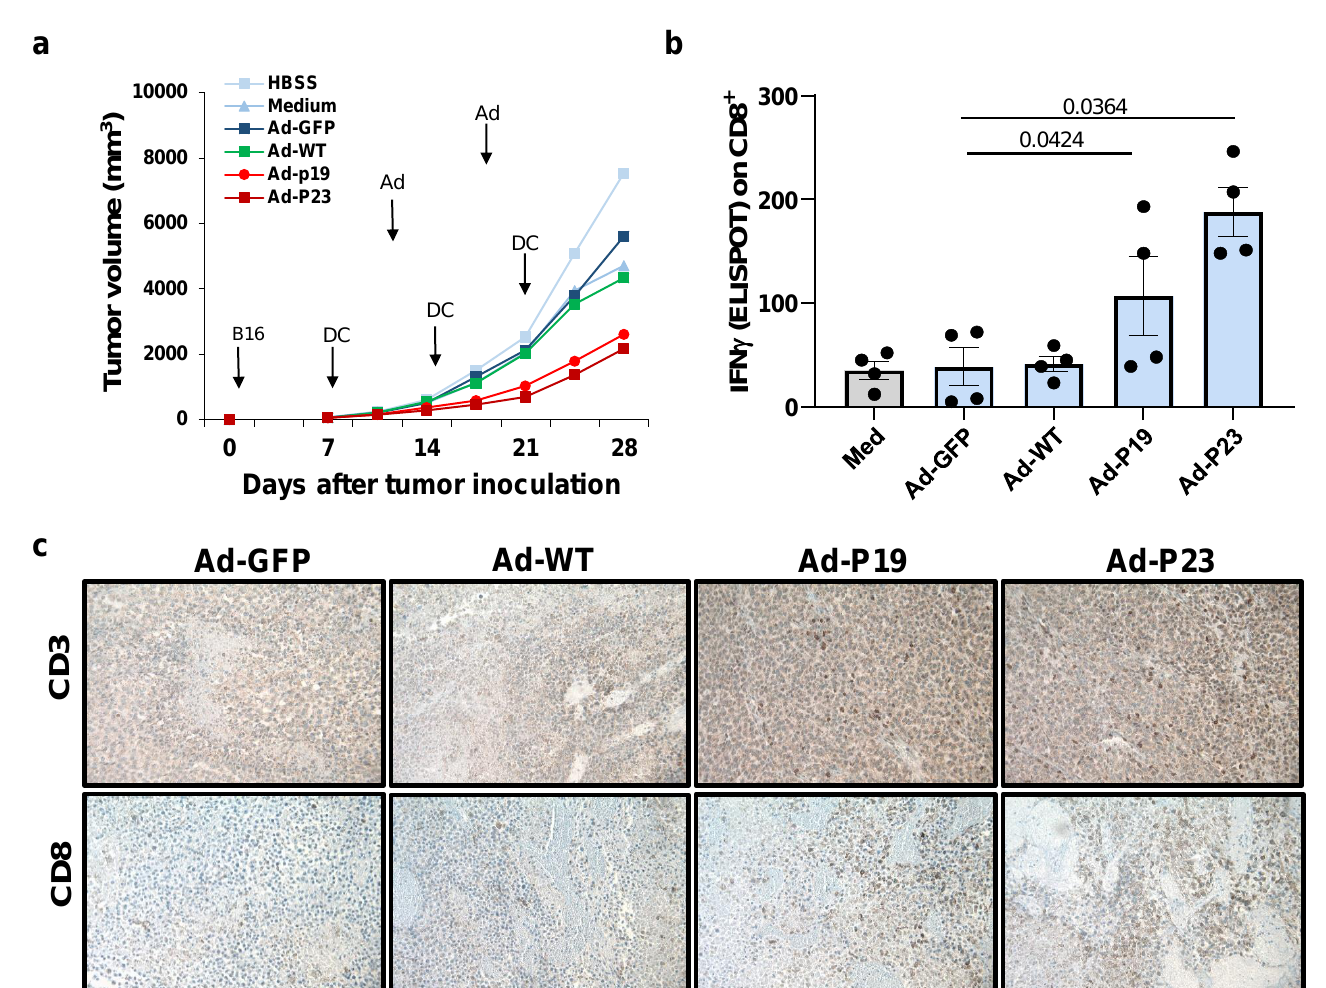
Figure 4. Suppression of tumor growth induced by intratumoral administration of Ad-P23-modified DCs. ( a ) Tumor volume increases (mm 3 , measured twice per week) in murine melanoma model of B16 cells (2.5 × 10 5 ) implanted subcutaneously in syngeneic C57BL/6 mice (n = 7/group) that received intratumoral transduced bone marrow DC (Medium-MED, untreated-, Ad-GFP, Ad-WT, Ad-P19, and Ad-P23, 5 × 10 6 cells per injection) on day 8 and weekly thereafter. Paired student t test was analyzed against all controls (HBSS, Medium, Ad-GFP, blue lines) and WT DAP12 (Ad-WT, green line). Ad-P19 and AdP23 (red lines) were significant against all after the 14-day time point ( p < 0.05). ( b ) EliSpot detection of IFN γ secretion from CD8 + T cells isolated from splenocytes of B16 murine melanoma model as in “a” sacrificed on day 28. The number of spots per 3 × 10 5 CD8 + T cells is shown, and p values were calculated using paired Student’s t test. ( c ) Immunohistochemical staining revealed that the number of tumor-infiltrating CD3 + T cells (top panels) and CD8 + T cells (bottom panels) in the group of mice treated with Ad-P19/DC or Ad-P23/DC was significantly greater than that in the group of mice treated with Ad-GFP/DC, Ad-WT/DC, or DC alone. Panels are representative of samples from 7 mice per group with similar staining profiles and images are displayed at × 200 magnification. Calculated p values of student t -test are in Supplemental Table S3 and ANOVA in Supplemental Figure S3b by calculating the